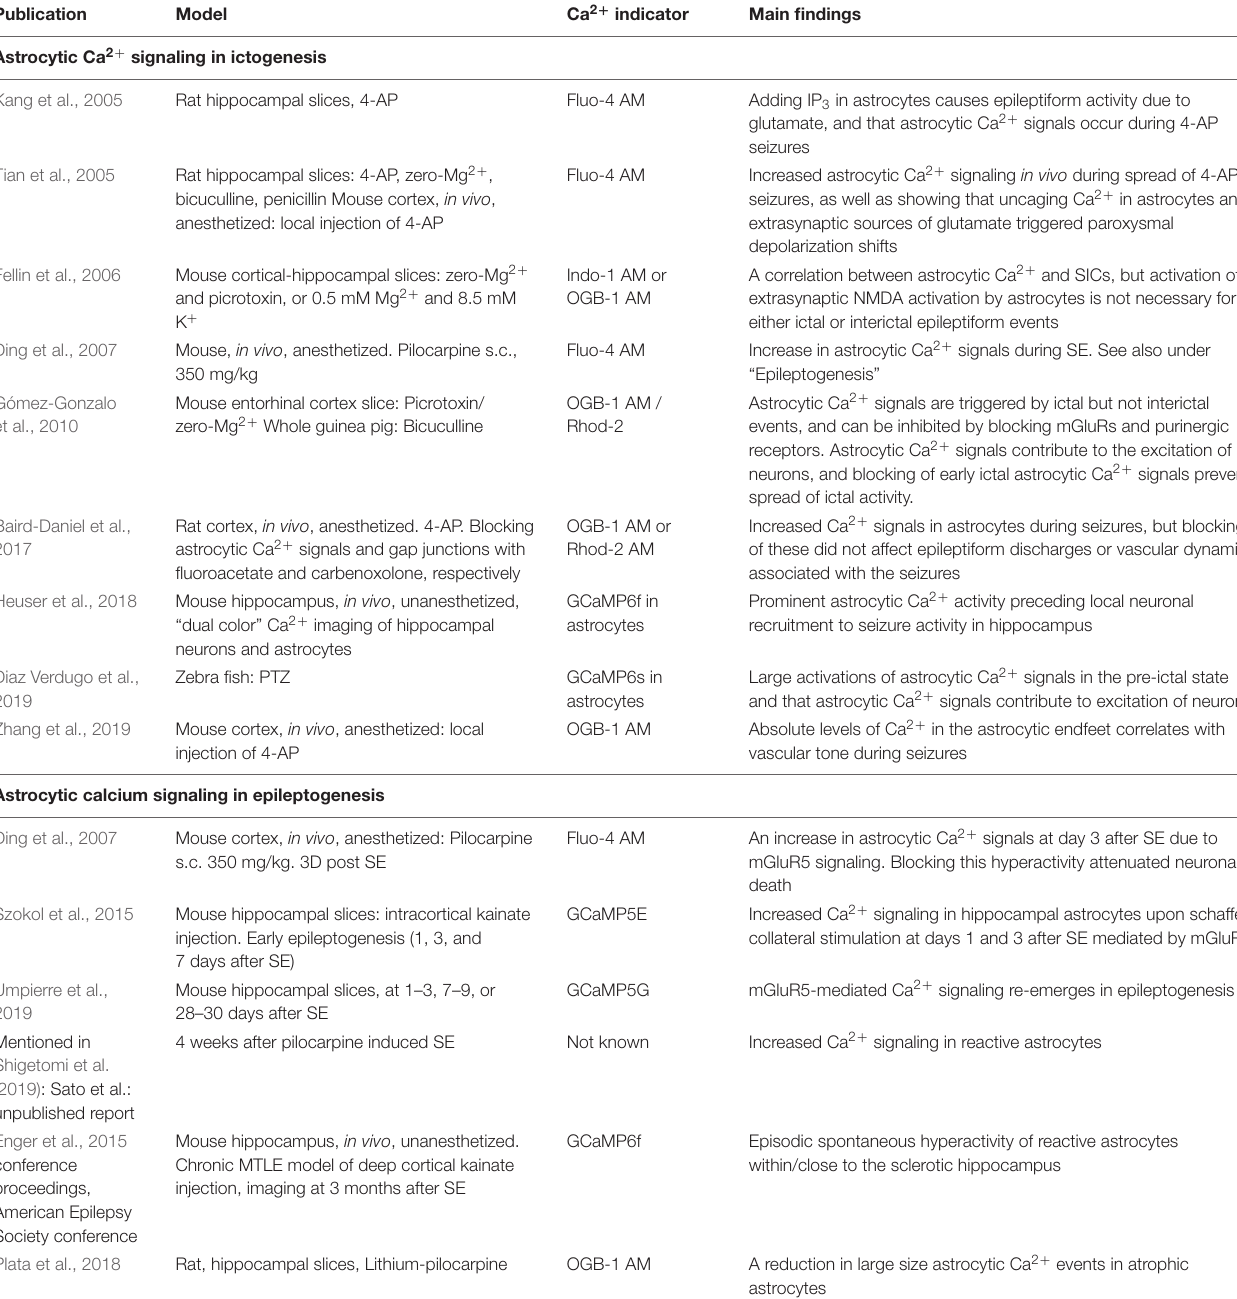
TABLE 1 | Key publications investigating the roles of astrocytic Ca 2 + signalling in ictogenesis and